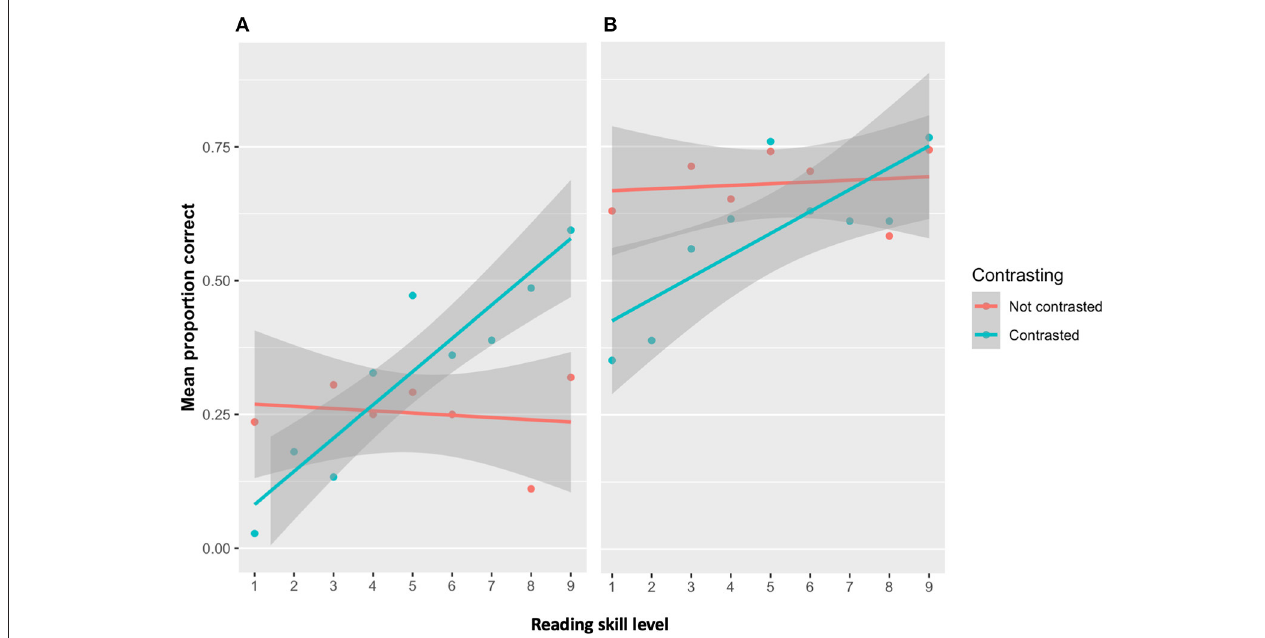
FIGURE 8 | The dots represent the average proportion of words remembered for all the children within a given level of reading skill (red = all children in the not contrasted condition, blue = all children in the contrasted condition). The shaded area represents the 95% confidence interval. (A) Effect of contrasting on the similar words during learning depends on reading skill level. Less skilled readers were negatively impacted by contrasting than skilled readers. (B) Effect of contrasting on the similar words on the post-tests depends on reading skill level. Contrasting leads to more remembering of the words, but only for skilled